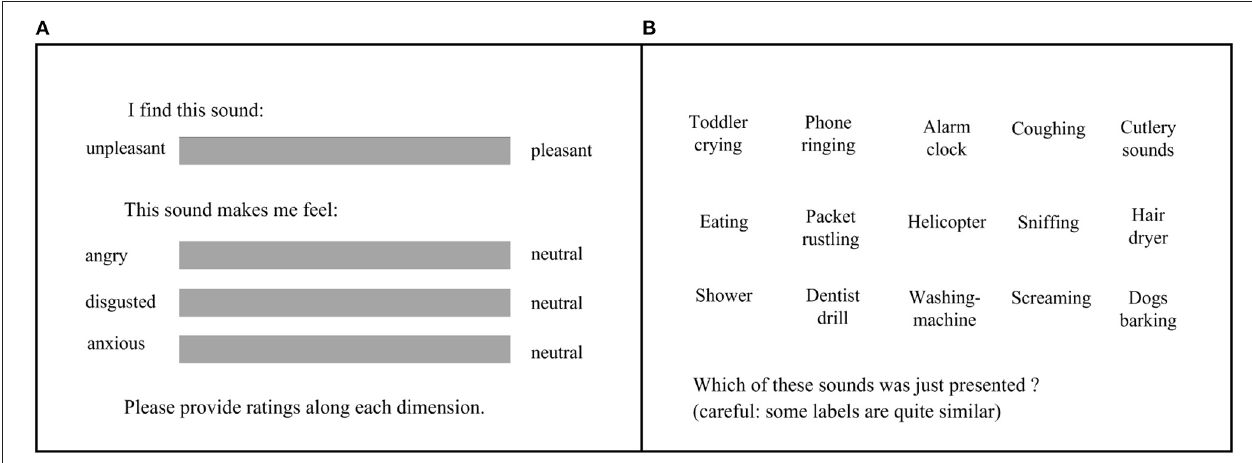
FIGURE 1 | (A) Subjective ratings. Participants had unlimited time to rate the pleasantness of the sound (from unpleasant to pleasant) and the subjective feelings of anger, disgust, and anxiety after hearing the sound. (B) 15-alternative forced-choice task. Participants had unlimited time to click on the label corresponding to the sound that they just